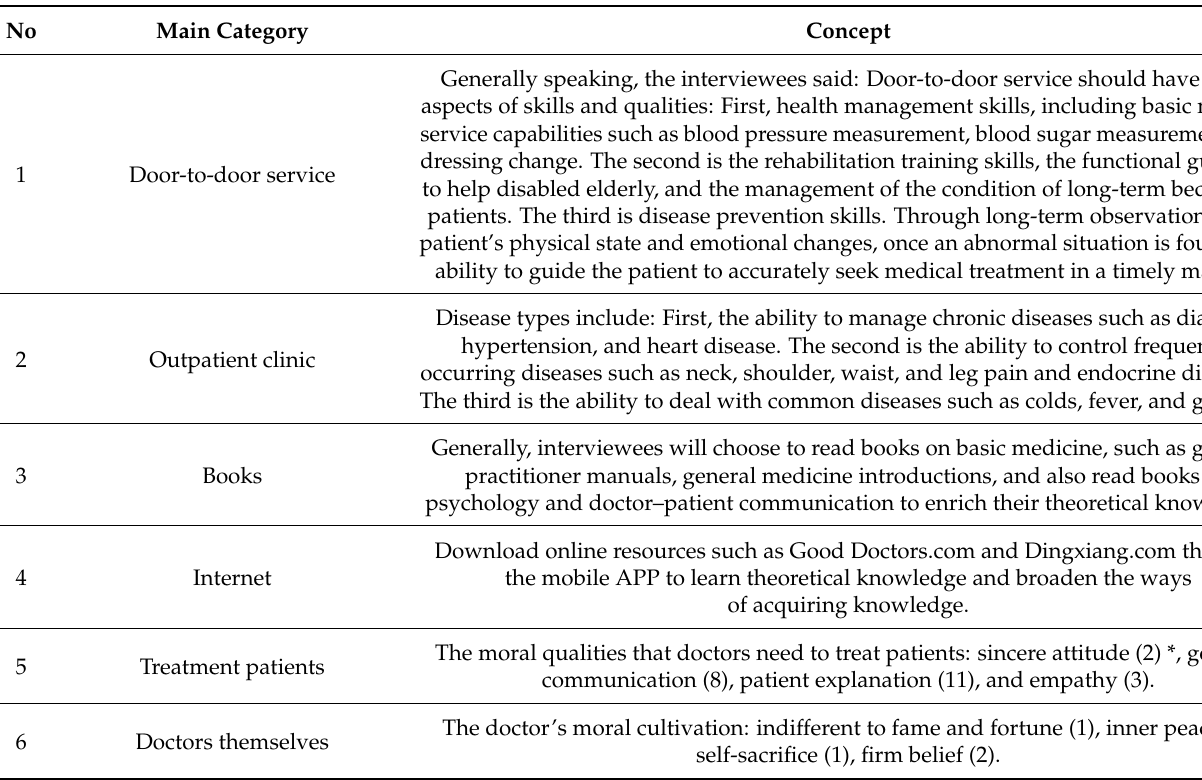
Table 1. Open coding